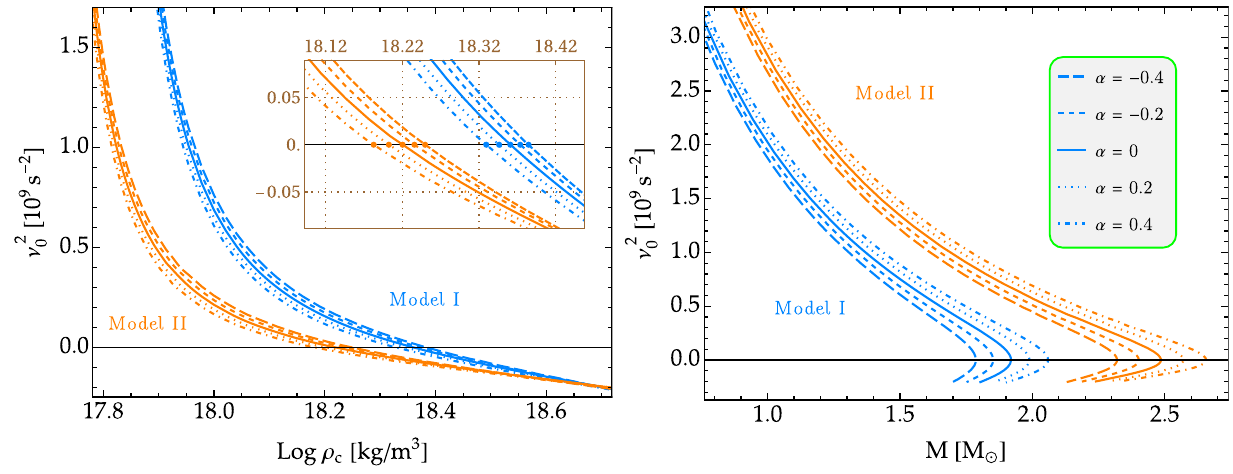
Fig. 6 Left panel: Squared frequency of the fundamental pulsation on the right plot of Fig. 3. Right plot: Squared frequency of the funda- mental mode versus gravitational mass, where it can be observed that mode as a function of central mass density for anisotropic dark energy the maximum-mass values determine the boundary between stable and stars predicted by Einstein gravity. The full blue and orange circles = 0, whose values pre- unstable stars indicate the central density values where ν 2 0 cisely correspond to the maximum-mass points on the M (ρ c ) curves